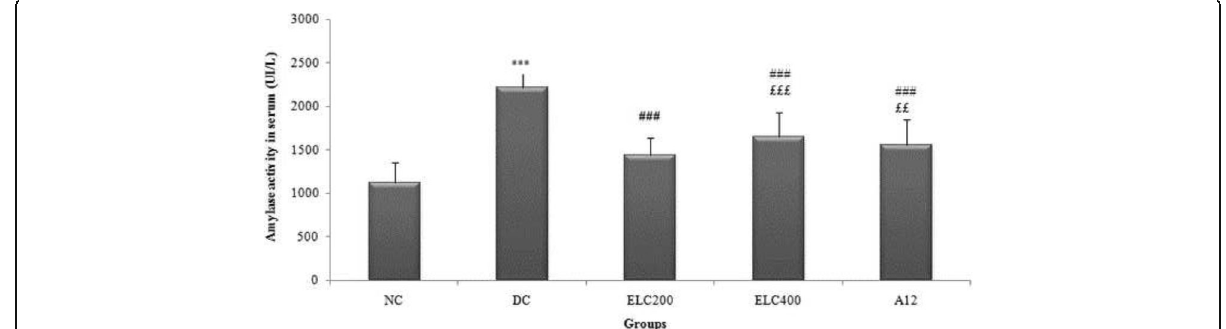
Fig. 5 Levels of α -amylase activity in serum of experimental groups of rats. Normal (NC) and Diabetic control (DC). ELC200&400: Ethanol extract from leaves of C. scolymus at doses of 200 and 400 mg/kg per day; A12: Acarbose at dose of 12 mg/kg per day for 28 days. The values are means ±SD ( n = 8 for each group). *** p ≤ 0.001 was considered significant compared to control group; #### p ≤ 0.001 was considered significant